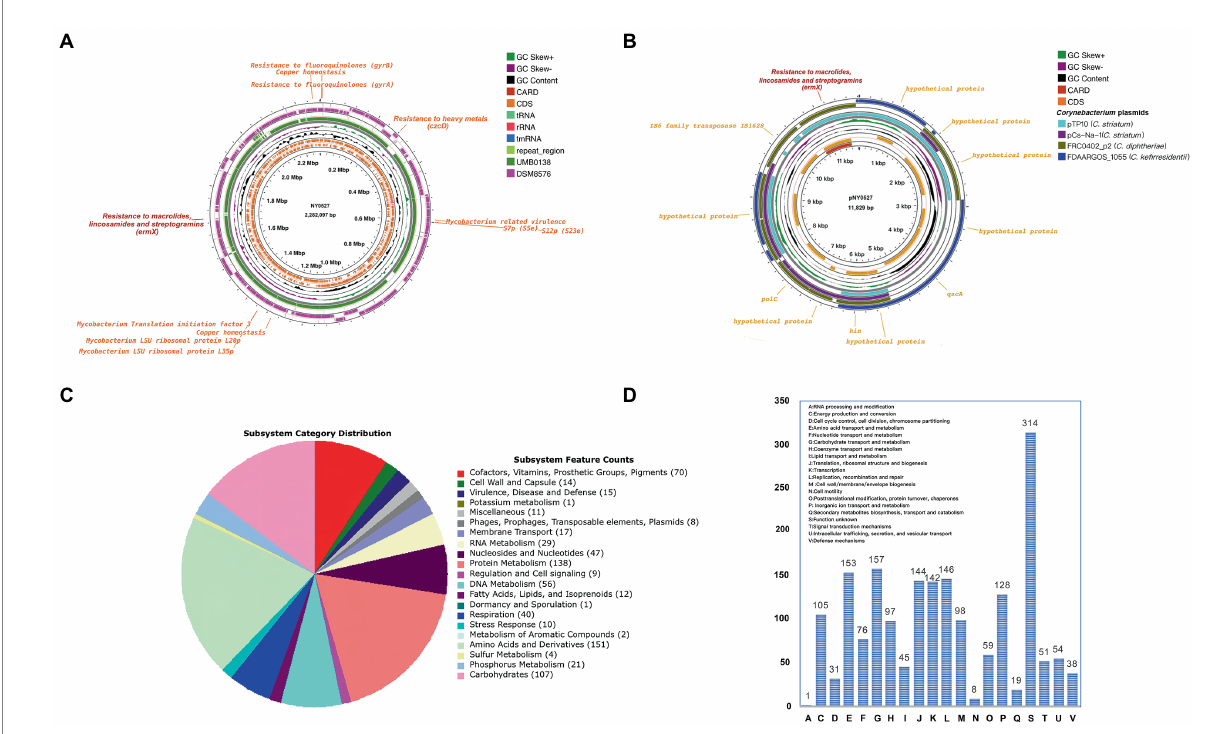
FIGURE 1 General genomic features of strain NY0527 characterized by the complete genome sequences. (A) The display of the circular chromosome sequence of strain NY0527. From inner to outer rings: genome backbone of strain NY0527 with ruler, antibiotic resistant genes, CDSs on the forward and reverse strands (RNAs and repeat sequence regions are displayed in the CDSs circles), GC content, GC skew, genome sequence of Actinomyces sp. UMB0138, genome sequence of W. neuii DSM8576 T . (B) The display of the circular plasmid sequence pNY0527. From inner to outer rings: genome backbone of pNY0527 with ruler, antibiotic resistant genes, CDSs on the forward and reverse strands, GC content, and GC skew. The legend on the right is shared by (A) and (B) . (C) Genomic subsystem functions annotated using the RAST. (D) Genomic COG functions annotated using the